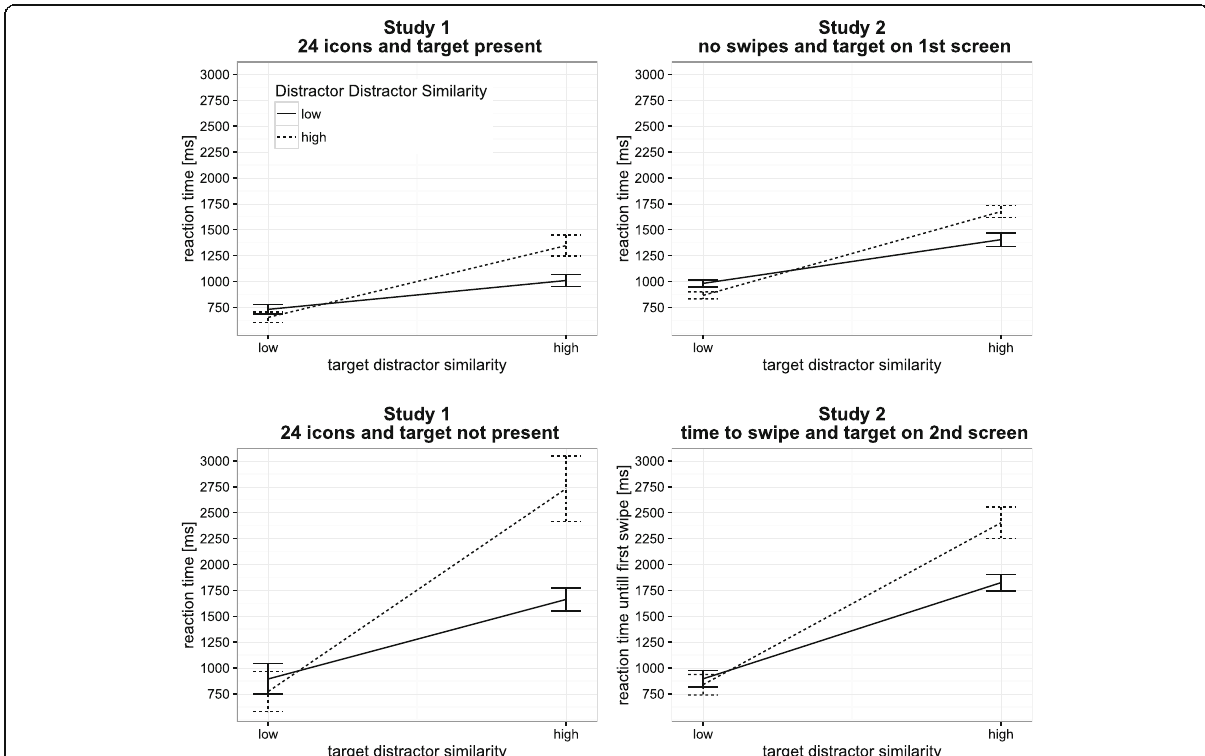
Fig. 6 Averaged reaction times of Study 1 and Study 2 in those conditions with 24 icons and a target on the first presented screen ( upper panel ) and in those conditions with 24 icons and the target not present on the first presented screen ( lower panel